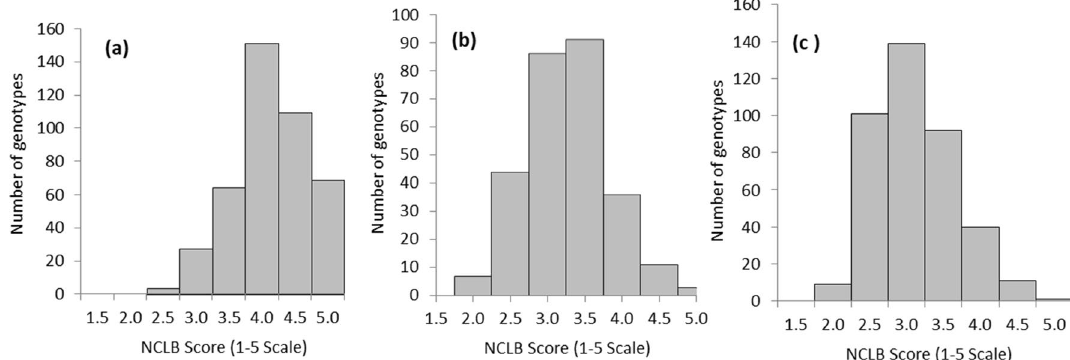
Figure 1. Phenotypic distribution of NCLB scores of ( a ) CAAM ( b ) DTMA and ( c ) IMAS panels on 1–5 scale with score 1 considered as highly resistant and score 5 as highly susceptible.